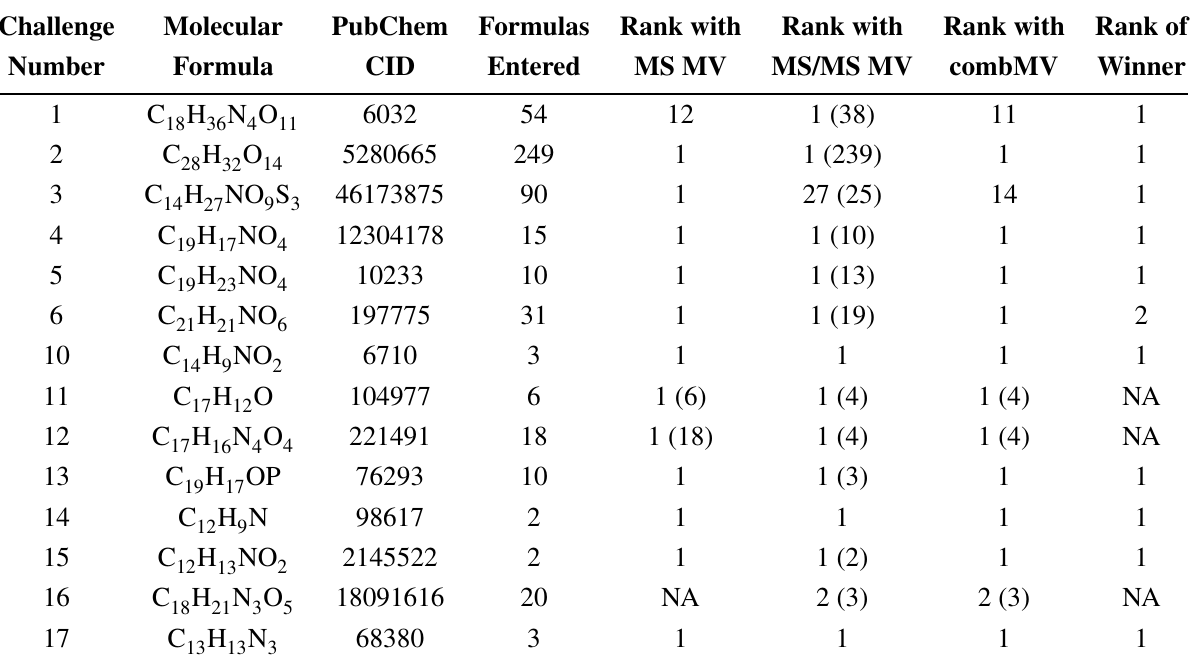
MOLGEN–MS/MS results for Category 1 (best molecular formula with LC–MS/MS data). Numbers in brackets denote the number of candidates with equal Remaining abbreviations: see